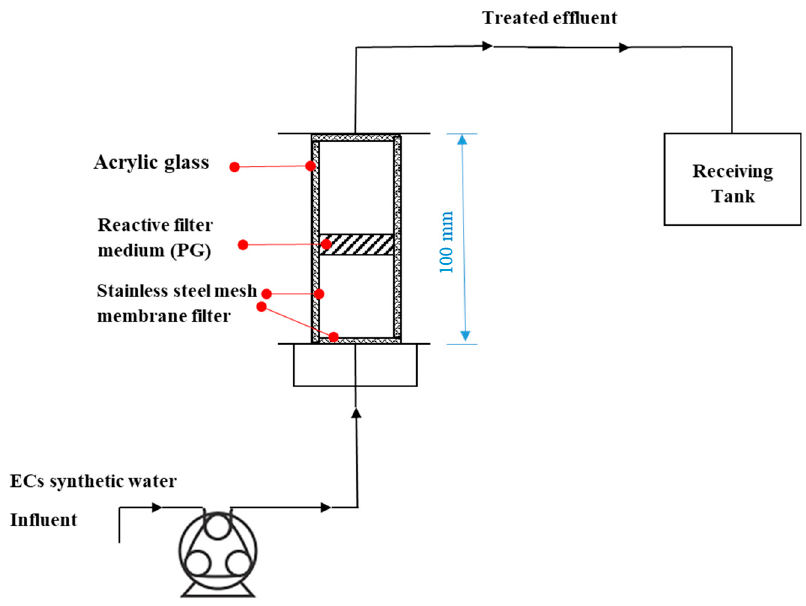
Figure 1. A schematic illustrating of the continuous flow set-up for the column tests.